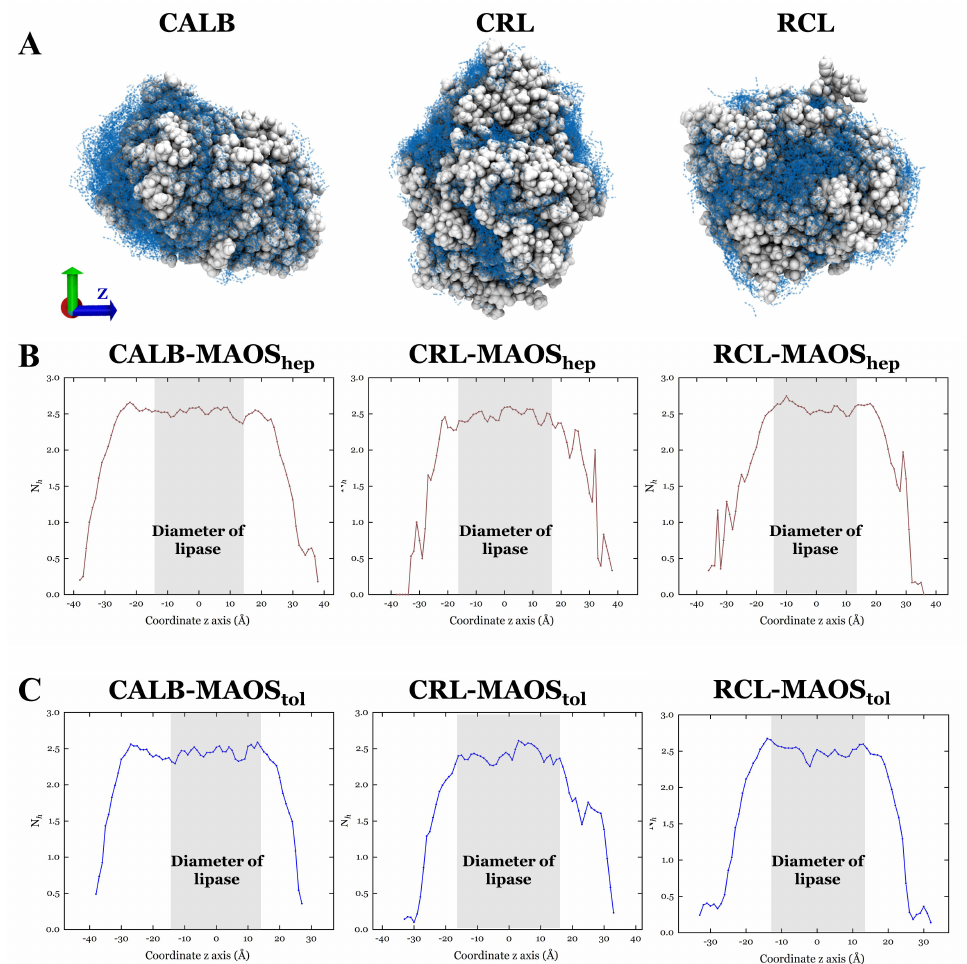
Figure 4. Hydrogen bonds formed by water molecules and the lipases in the MAOS systems ( A ). Distribution of hydrogen bonds formed by water molecules along the z -axis in the MAOS hep ( B ) and MAOS tol ( C